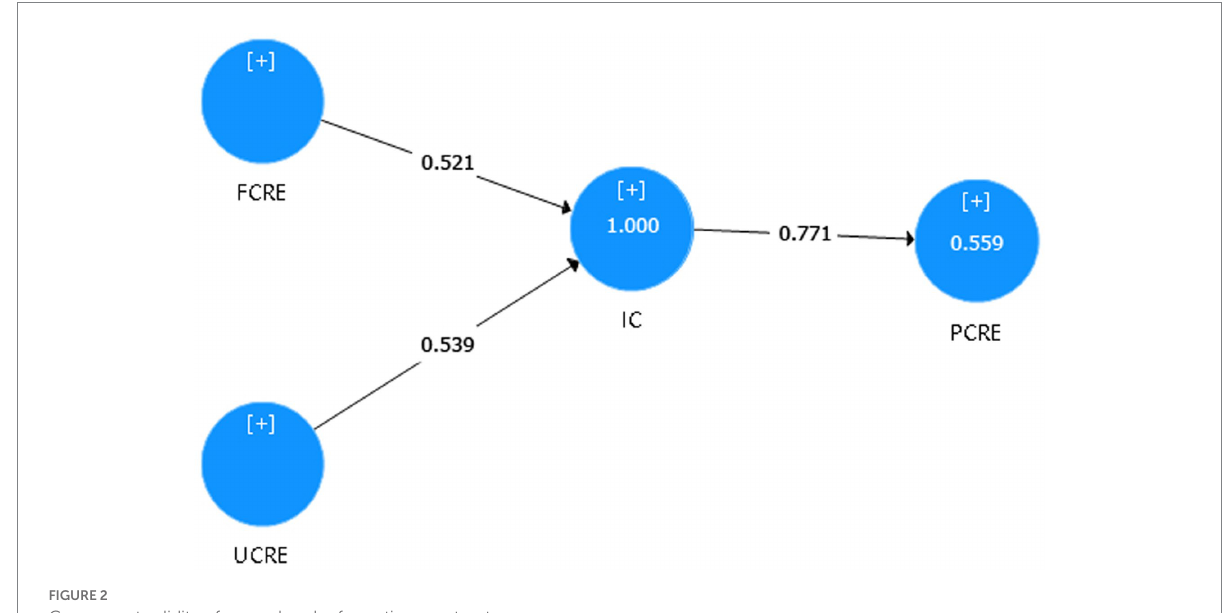
FIGURE 2 Convergent validity of second-order formative